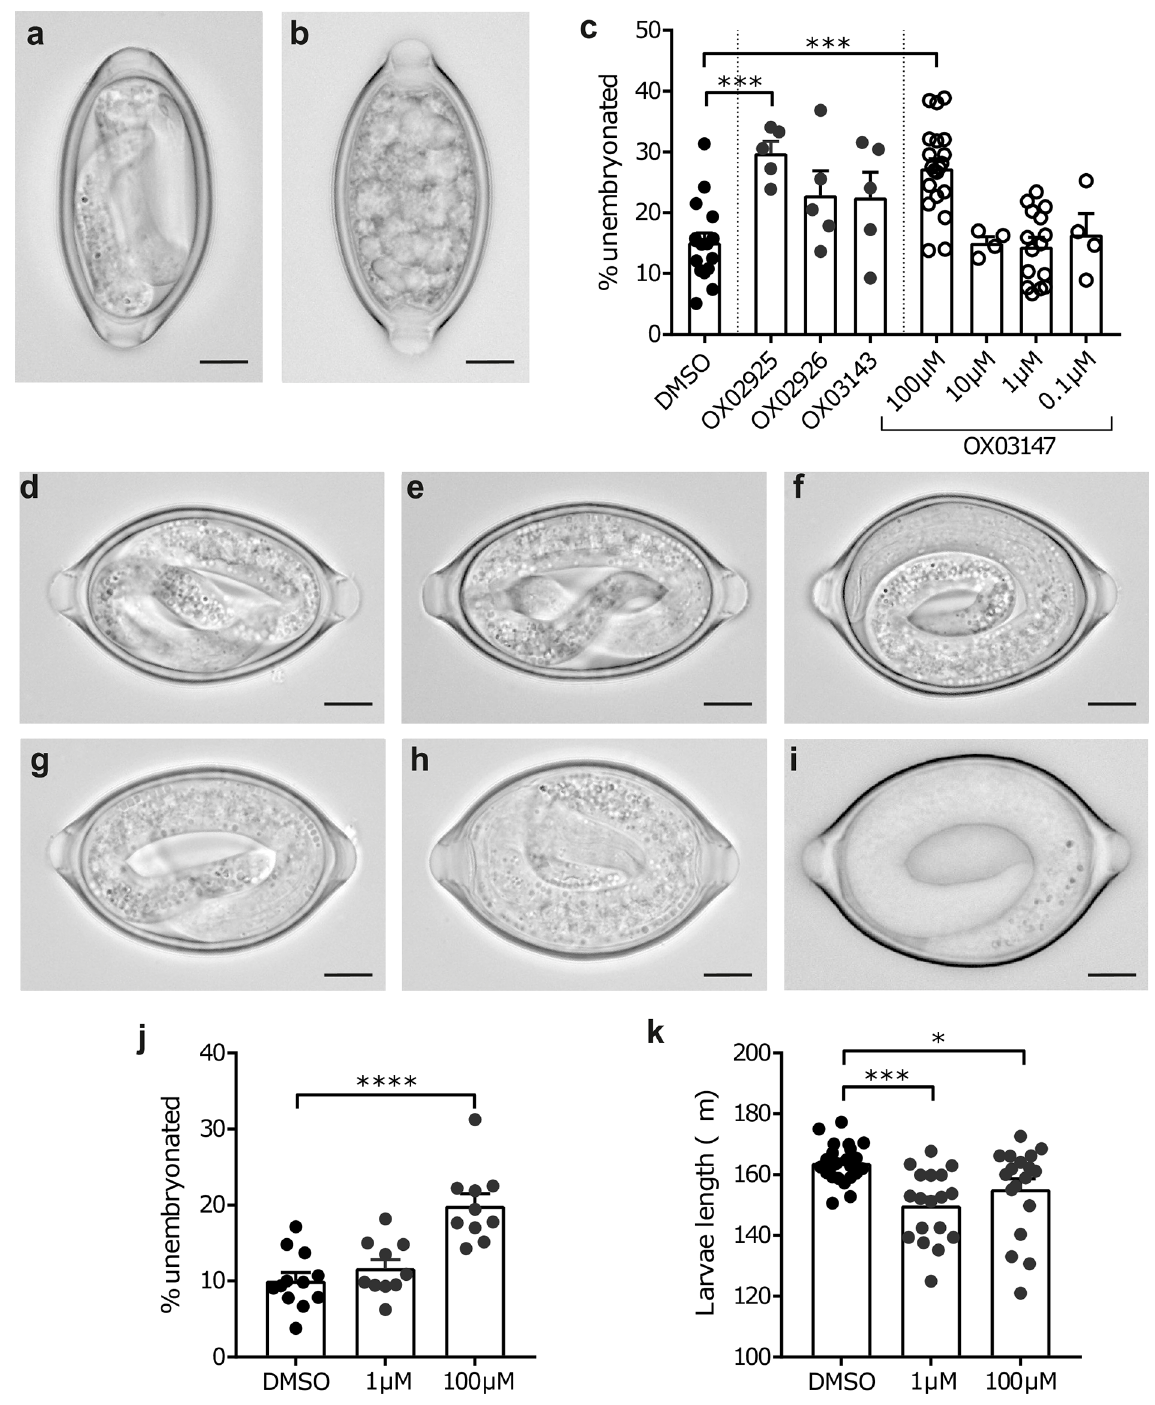
Fig 7. Unembryonated T . muris eggs treated with diaminothienopyrimidines have altered embryonation. Unembyronated eggs were soaked in 100 μM compound (unless specified otherwise) at 26˚C (unless specified otherwise) for the duration of the embryonation process (56–60 days) and then embryonation determined and eggs imaged using an Olympus BX63 microscope. Scale bar indicates 10 μ m. (a) Typical embryonated egg and (b) unembryonated egg. (c) treatment with DATPs increased the incidence of unembryonated eggs. Representative pictures of (d) DMSO, (e) OX02925 , (f) OX02926 , (g) OX03143 and (h) OX03147 100 μM and (i) OX03147 1 μM soaked T . muris eggs. (j) Unembyronated eggs soaked in OX03147 at room temperature for 56 days and embryonation determined. (k) Unembyronated eggs soaked in OX03147 at 26˚C for 56 days and larval length calculated using